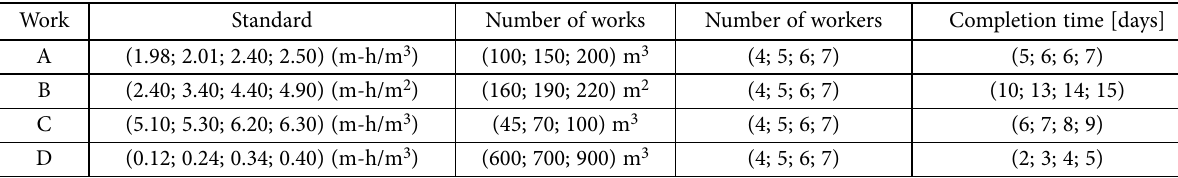
Table 3. Fuzzy data in the relationship network according to Figure 1